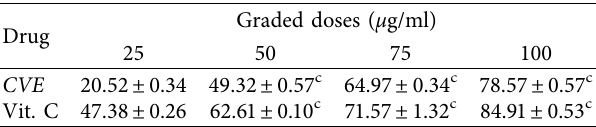
Table 5: In vitro nitric oxide- (NO-) scavenging activity of 25–100 μ g/ml of CVE and vitamin C. Drug